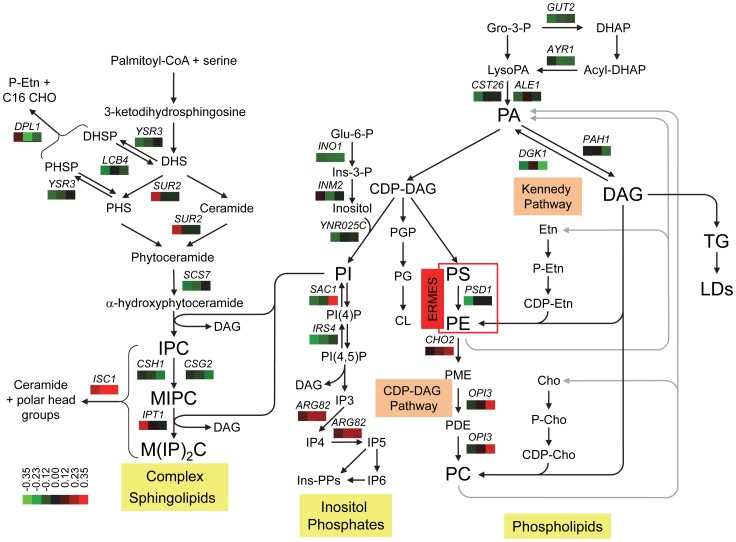
Genetic interactions of SCS3 and YFT2 map to sphingolipid, phospholipid, and inositol phosphate synthesis pathways.Cross-talk between the different pathways is illustrated by the central role of PI synthesis and DAG production/utilization. The arrangement of the steps in the Kennedy and CDP-DAG pathways for the synthesis of PC is modified from Carman and Han [47]. The role of the ERMES complex in transporting PS from the ER to the mitochondria for conversion to PE and its return to the ER [50] is represented by a red box. Genes encoding all four components of the complex (MDM10, MDM12, MDM34 and MMM1) exhibited alleviating interactions when both SCS3 and YFT2 were deleted (Table S1; the alleviating interaction between MDM10 and the SCS3 YFT2 double deletion was identified with relaxed criteria, 38 pixel size difference, p = 0.006, ε = 0.18). The synthesis of PE and PC from lysoPE and lyso PC is omitted for clarity. The steps in the synthesis of inositol phosphates are modified from York [52]. The pathway for the synthesis of complex sphingolipids is modified from Dickson [53]. Steps involving genes that interact genetically with SCS3 and/or YFT2 show the gene name above three boxes which indicate the relative strength and sign of the interactions. Aggravating (green) and alleviating (red) interactions are ordered from left to right for the scs3
Δ, yft2
Δ and scs3
Δ
yft2
Δ strains using the values in Table S1. A colorbar shows the intensity of the interactions. Phosphatidic acid, PA; diacylglycerol, DAG; triglyceride, TG; lipid droplet, LD, Gro, glycerol; DHAP, dihydroxyacetone phosphate; Glu, glucose; Ins, inositol; PME, phosphatidyl monomethylethanolamine; PDE, phosphatidyl dimethylethanolamine; Etn, ethanolamine; Cho, choline., dihydrosphingosine, DHS; phytosphingosine, PHS; inositolphosphoceramide, IPC; mannosyl-inositolphosphoceramide, MIPC; mannosyl-diinositolphosphoceramide, M(IP)2.